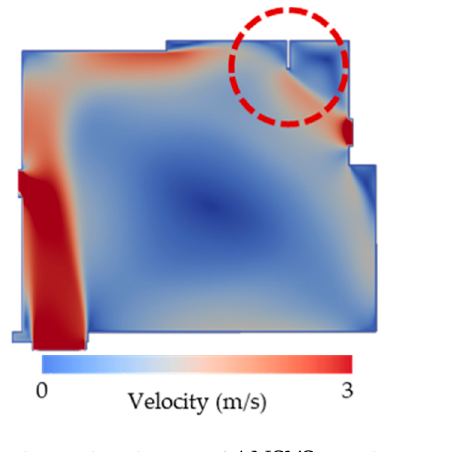
Figure 6. Difference in velocity distribution at A-type according to optimization.